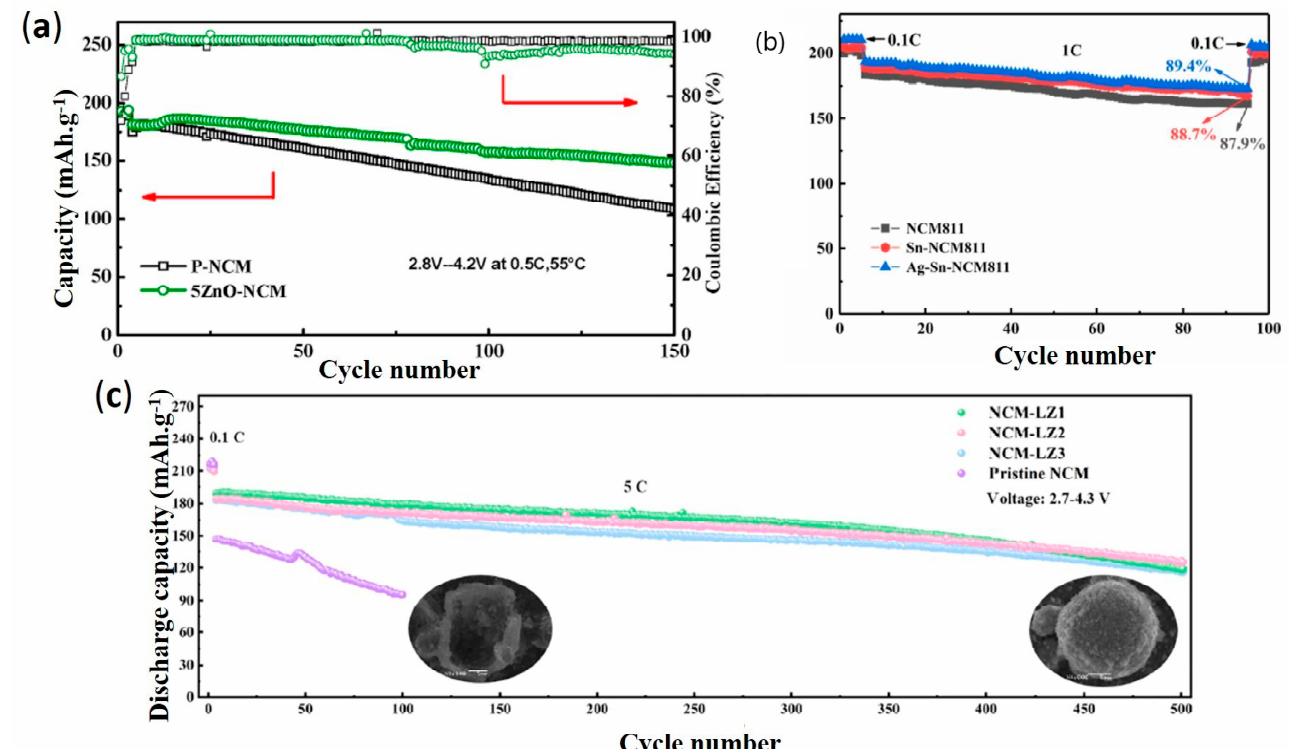
Figure 6. ( a ) Cyclic performance at 55 ◦ C of NCM and 5ZnO-NCM [150], ( b ) Cycling performance of NCM811, Sn- NCM811, and Ag-Sn-NCM811 (1 C = 200 mA · g − 1 , at the range of 2.8–4.3 V) [151], and ( c ) Cycling performance of the a La 2 Zr 2 O 7 -coated NCM samples at 5 C